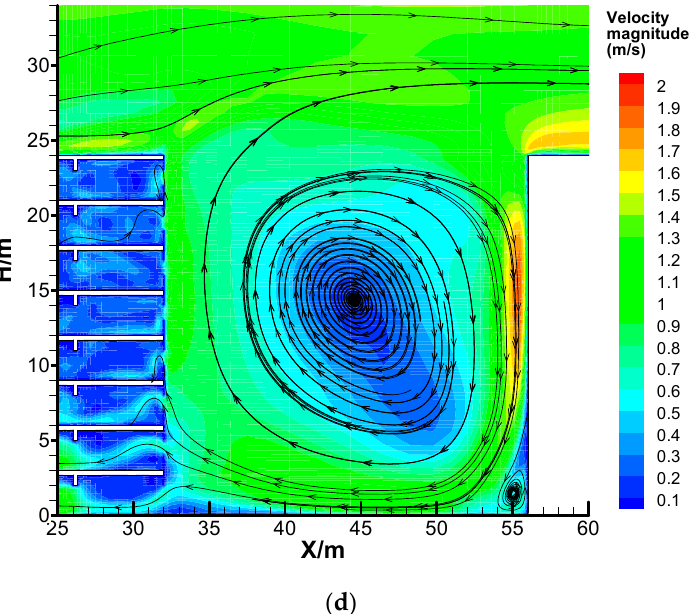
Figure 5. Streamline and velocity in street canyons with cross-ventilation mode under isothermal condition in the target canyon ( a ); with indoor wall-heating condition in ( b ) the target canyon, ( c ) canyon 2 and ( d ) canyon 4.